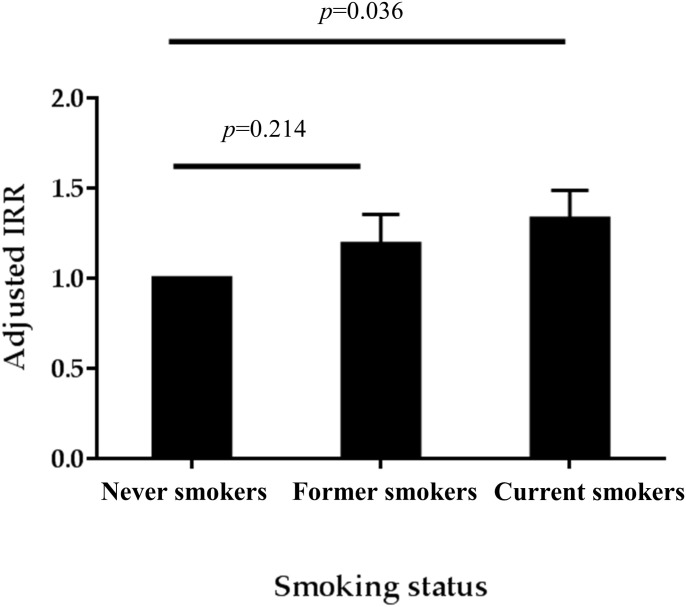
Adjusted incidence rate ratio of CKD according to smoking status.Abbreviation: IRR, incidence rate ratio.